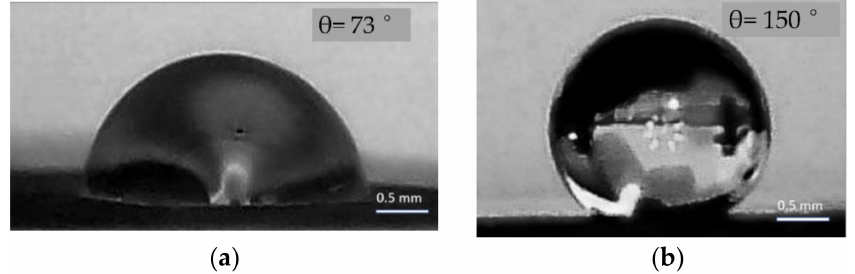
Figure 8. Forms of water droplets and magnitude of contact angles on the surface of titanium oxides of types M ( a ) and A ( b